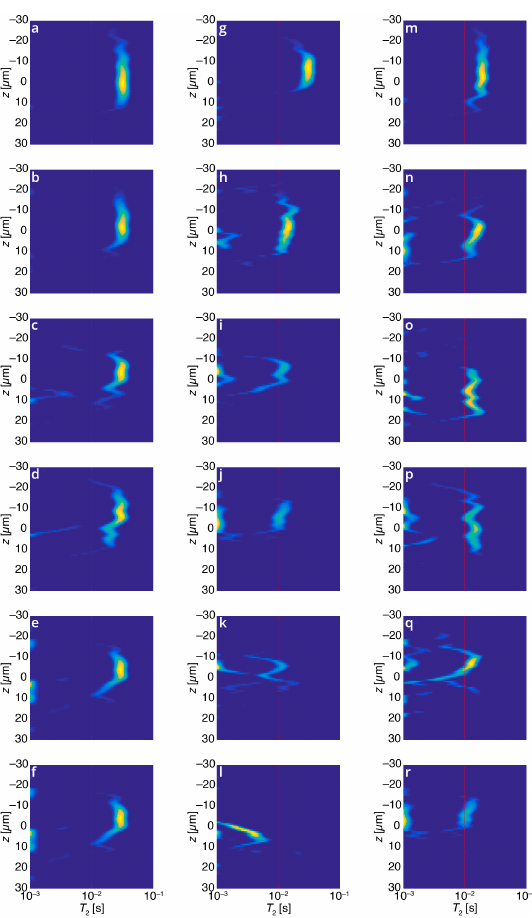
Figure 4. Relaxation cross-linking (or z – T 2 ) maps for various coating samples, all with identical horizontal and vertical axes: ( a – f ) 0% triphenylphosphine (PPh 3 ), UV powers of (top to bottom) 0%, 20%, 40%, 60% 80%, and 100% for 30 s curing. The T 2 values are unaffected by UV intensity, suggesting that without the scavenger PPh 3 , no measurable curing of the sample occurs due to interferences from atmospheric oxygen; ( g – l ) Varying concentrations of scavenger PPh 3 (top to bottom: 0%, 0.2%, 0.5%, 1%, 2%, 5% w / w ) with constant (100%) UV intensity. The measured T 2 values decrease with increasing PPh 3 content, showing the scavenger’s ability to facilitate curing despite atmospheric interference from oxygen; ( m – r ) One percent PPh 3 , UV powers of (top to bottom) 0%, 20%, 40%, 60% 80%, and 100% for 30 s curing. In contrast to the leftmost column, when 1% PPh 3 is added to the sample as a radical in the measured T 2